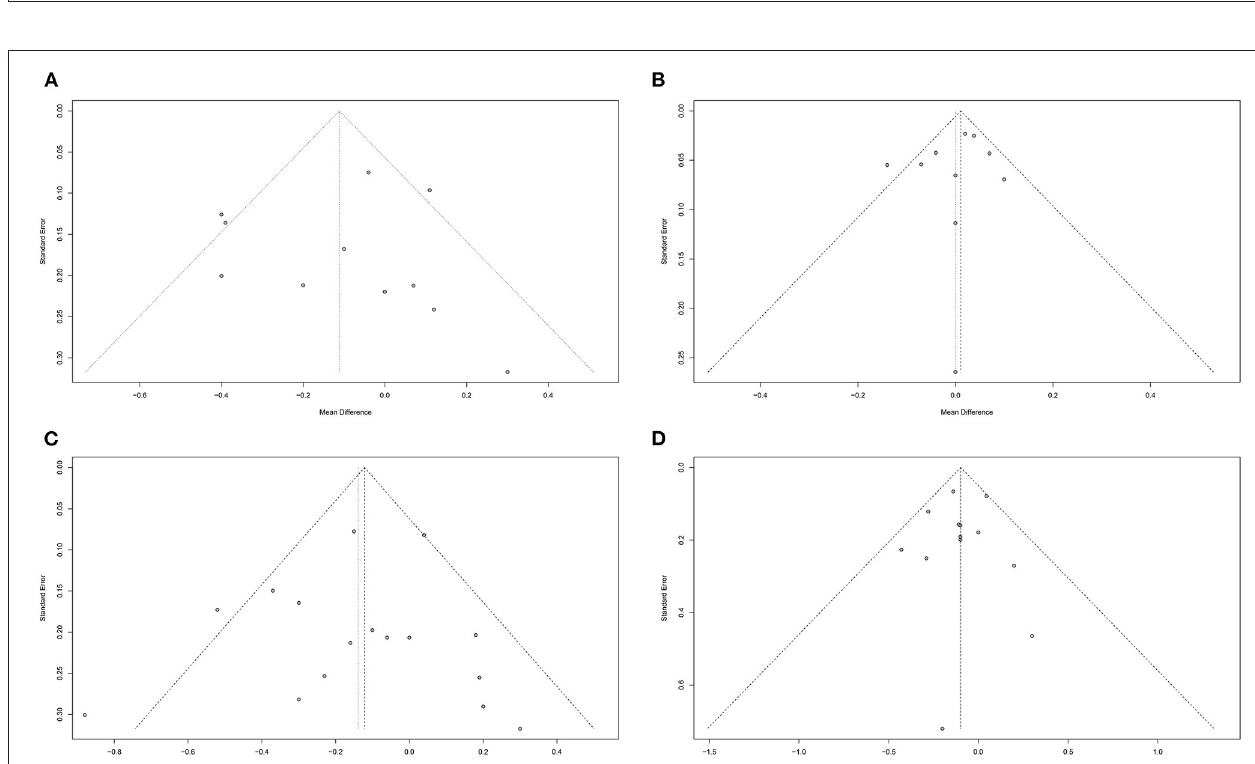
FIGURE 7 | Funnel plots to evaluate publication bias, and effect of peanuts and tree nuts intake for (A) LDL-C Egger’s test ( p = 0.851), (B) HDL-C Egger’s test ( p = 0.460), (C) TC Egger’s test ( p = 0.670), and (D) TG Egger’s test ( p = 0.884) in patients with type 2 diabetes. HDL-C, high-density lipoprotein-cholesterol; LDL-C, low-density lipoprotein-cholesterol; TC, total cholesterol; TG, triglyceride; WMD, weighted mean difference.